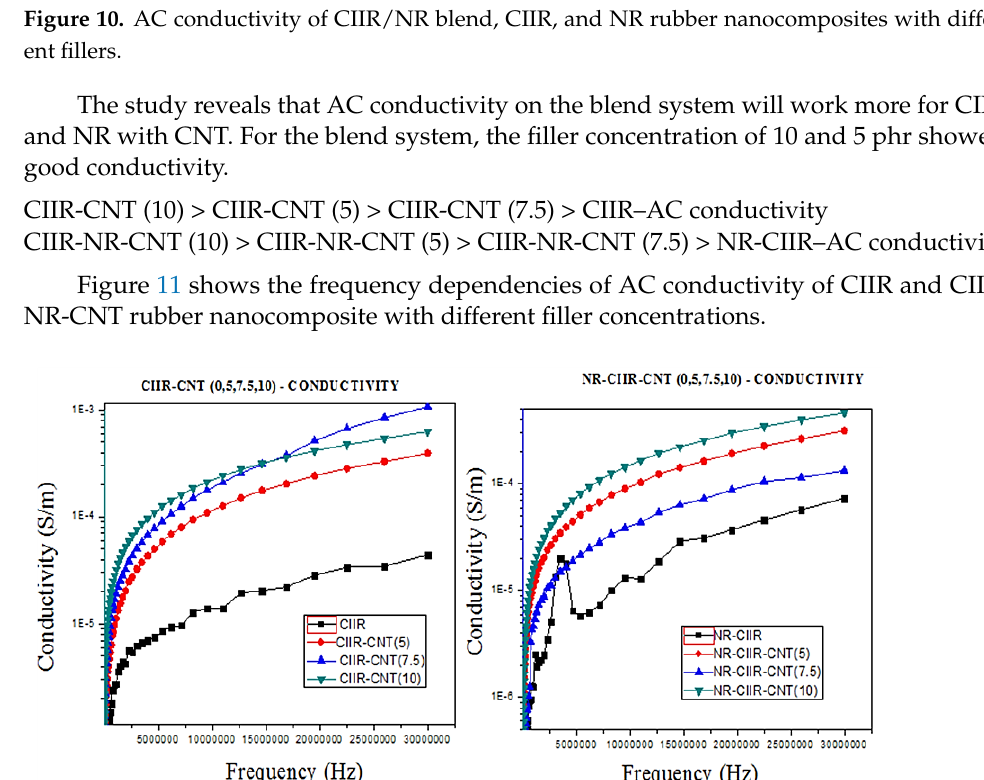
Figure 10. AC conductivity of CIIR/NR blend, CIIR, and NR rubber nanocomposites with different fillers.